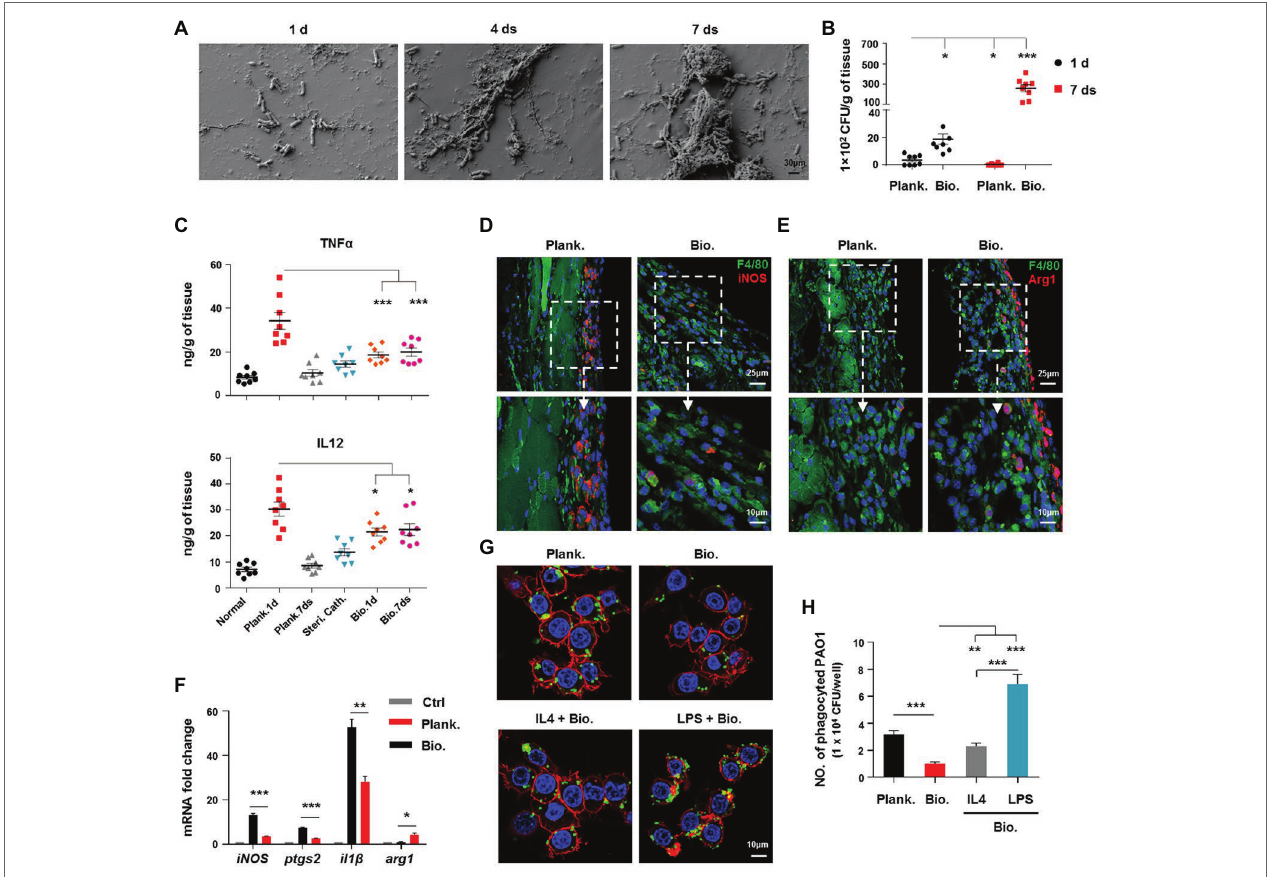
FIGURE 1 | Pseudomonas aeruginosa biofilm persistence is associated with attenuated activation of host proinflammtory responses and decreased bacterial eradication ability, whereas increased programming of macrophages toward M2 phenotype. (A) P. aeruginosa biofilm formation on catheters was observed by scanning electron microscopy (SEM; 5000X magnification). Bacterial loads (B) , production of tumor necrosis factor (TNF α ) and IL12 p40/70 (C) , and F4/80 + /iNOS + and F4/80 + /Arg1 + macrophages (D,E) in planktonic P. aeruginosa (1 day)‐ or catheter biofilm (7 days)-infected tissues were determined by colony forming unit (CFU) enumeration, enzyme-linked immunosorbent assay (ELISA), and immunofluorescence staining, respectively. For immunofluorescence staining, M1 macrophages were counterstained with fluorescein isothiocyanate (FITC)-conjugated anti-F4/80 and AF647-conjugated anti-inducible nitric oxide synthase (iNOS) antibodies. M2 macrophages were counterstained with FITC-conjugated anti-F4/80 and AF647-conjugated anti-Arg1 antibodies; cellular nuclei were stained with 4 ′ ,6-diamidino-2-phenylindole (DAPI). The static P. aeruginosa biofilms were co-cultured with Raw264.7 at 37 ° C, with 5% CO 2 for 3 h (MOI = 10), and relative gene expression levels were analyzed by real-time quantitative PCR (RT-qPCR) using mouse GAPDH as a reference gene (F) . To generate M1 and M2-polarized macrophages, Raw264.7 cells were pretreated with 100 ng/ml lipopolysaccharide (LPS) + 50 ng/ml IFN γ (named as LPS group) or 20 ng/ml IL4 for 6 h, respectively. The cells were then co-cultured with static P. aeruginosa biofilms at a ratio of 1:10 at 37 ° C, 5% CO 2 for 30 min. Phagocytosis was detected by immunofluorescence staining (G) and CFU enumeration (H) . Cytoskeleton was labeled with phalloidin (red); PAO1 was visualized by FITC anti-PAO1 antibody (green); cellular nuclei were stained with DAPI (blue). Error bars indicate the means ± standard errors of the means (SEM). An unpaired Student’s t test was used for statistical analysis (B,C,F,H) . * p < 0.05; ** p < 0.01; *** p < 0.001. Planktonic (Plank.), biofilm (Bio.), sterile catheter (steri